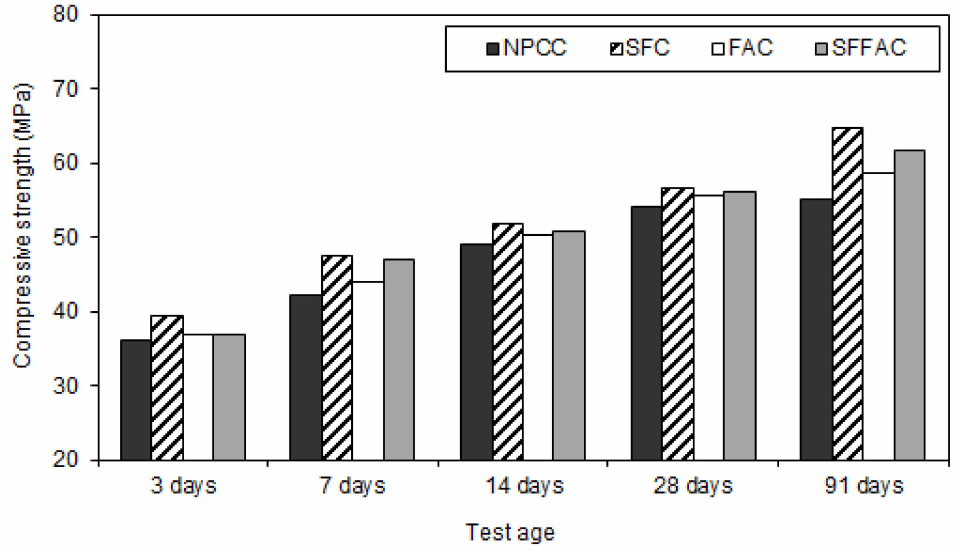
Figure 2. The compressive strength of different types of concrete at various ages after water curing at a medium temperature of 20 ˝